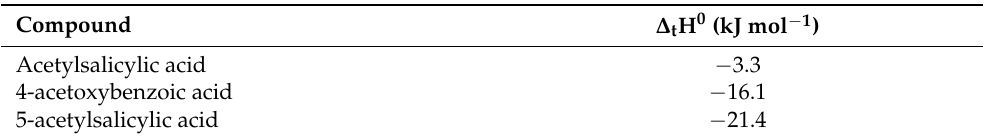
Table 6. Derived enthalpies of transfer of acetylsalicylic acid, 4-acetoxybenzoic acid and 5- acetylsalicylic acid from water to DMF at 298.15 K.